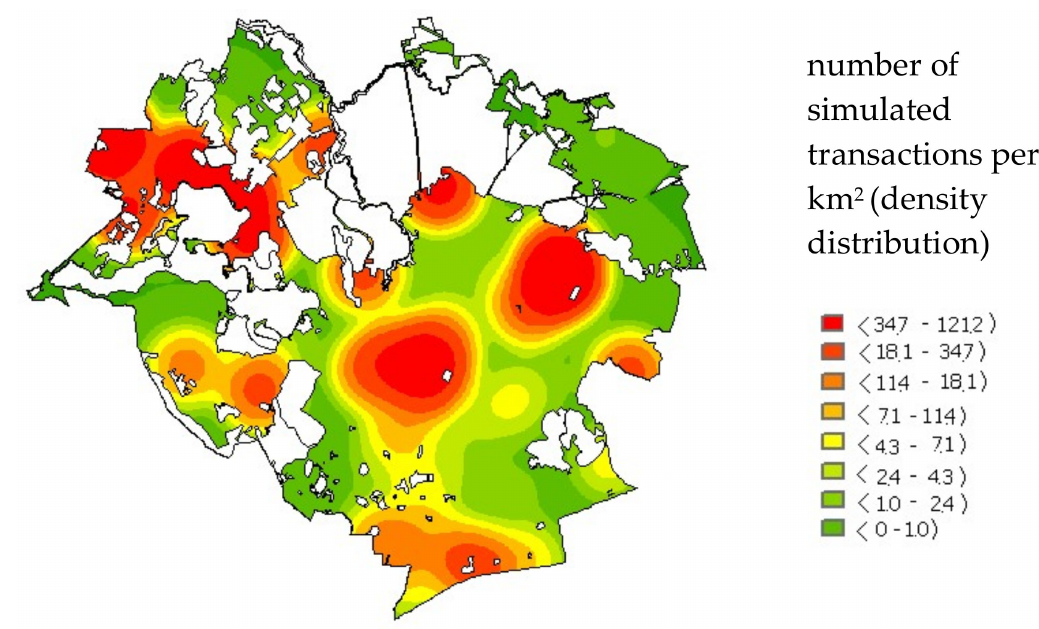
Figure 12. Map of simulated transaction